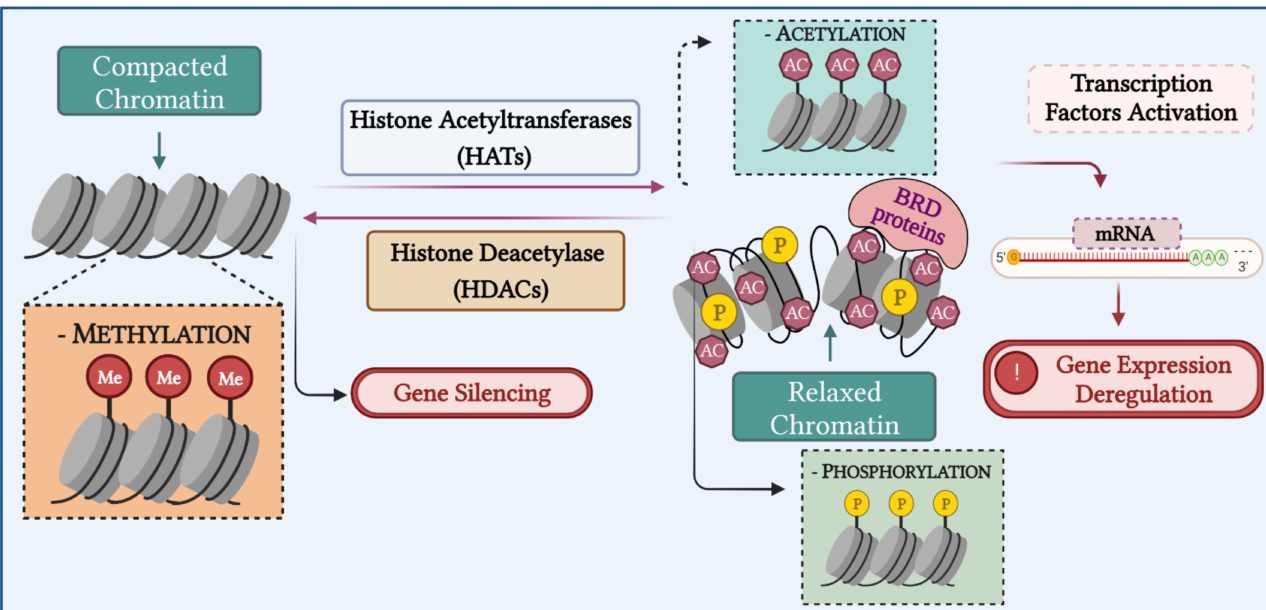
Figure 4. Chromatin remodeling process in LMS and ESS. Chromatin remodeling is an important mechanism of gene expression regulation. In the histone acetylation induced by HATs, the condensed chromatin is transformed into a more relaxed structure (euchromatin) that is associated with greater levels of gene transcription, while histone hypoacetylation induced by HDAC activity is associated with more condensed chromatin (heterochromatin), inducing gene silencing. Altered expression and mutations of genes that encode HDACs have been linked to tumor development. Created with